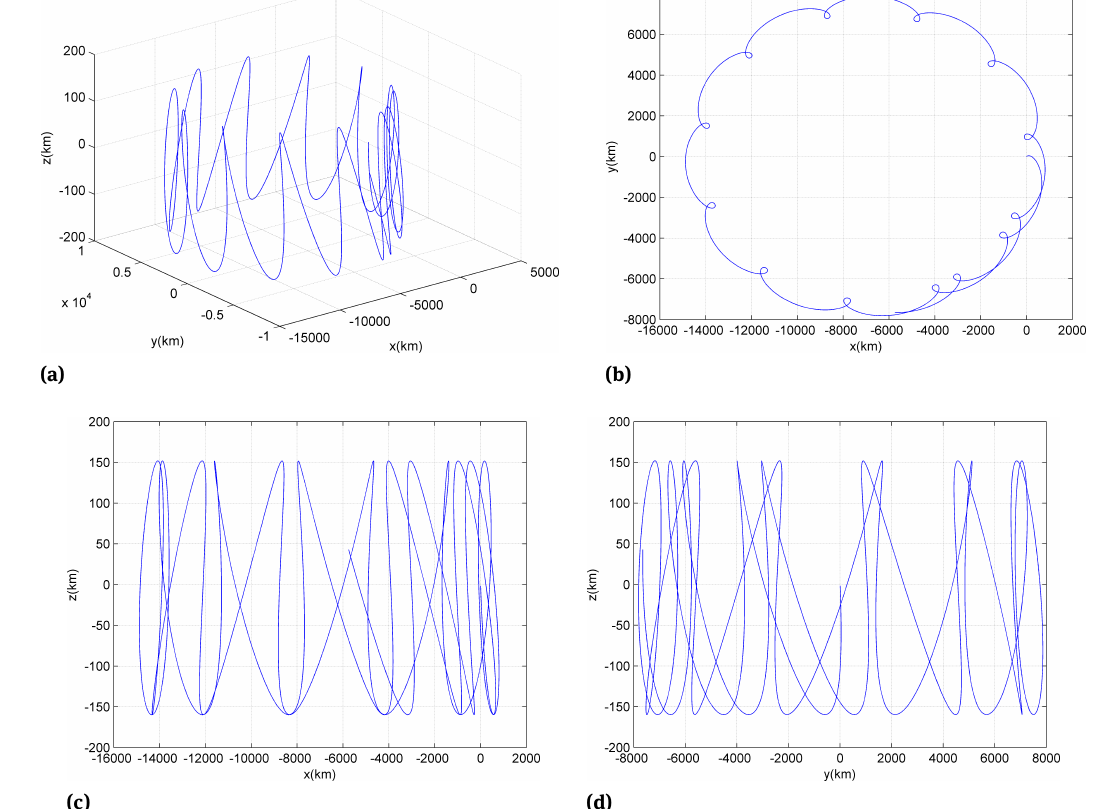
Figure 3. The relative position of object B relative to object A in the coordinate frame A-xyz . (a) 3D view; (b) xy plane; (c) xz plane; (d) yz plane.